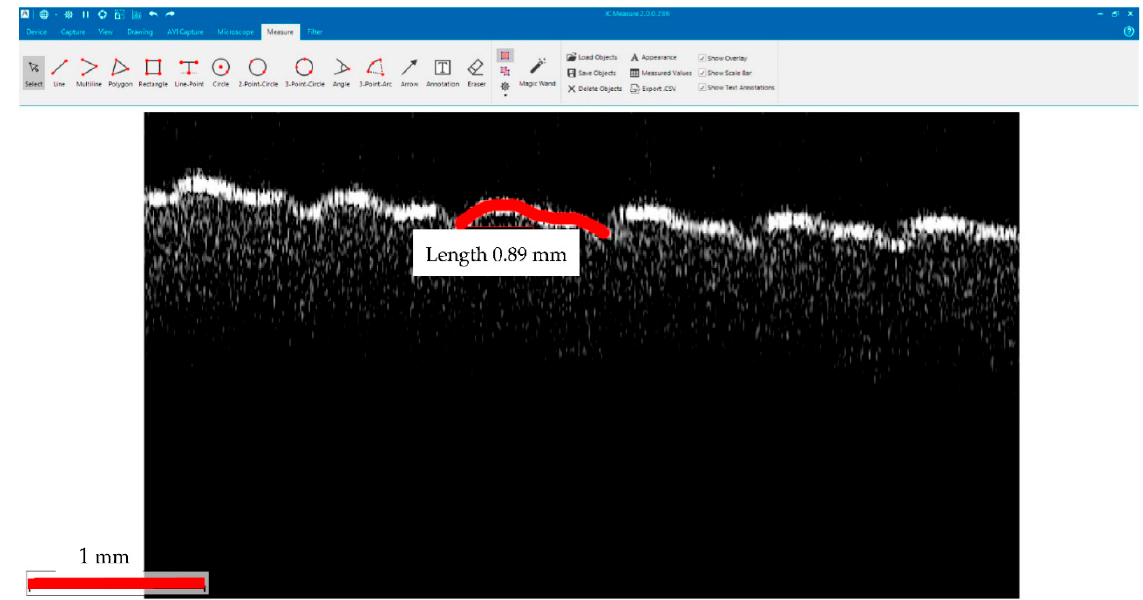
Figure 7. B-scan processed using the IC Measure program (The Imaging Source Europe GmbH, Bremen, Germany) in order to evaluate the lengths of the upper portions of each considered B-scan. The dimensions of the image are 3.5 (lateral) × 1.96 (vertical, along depth measured in air) mm 2 .